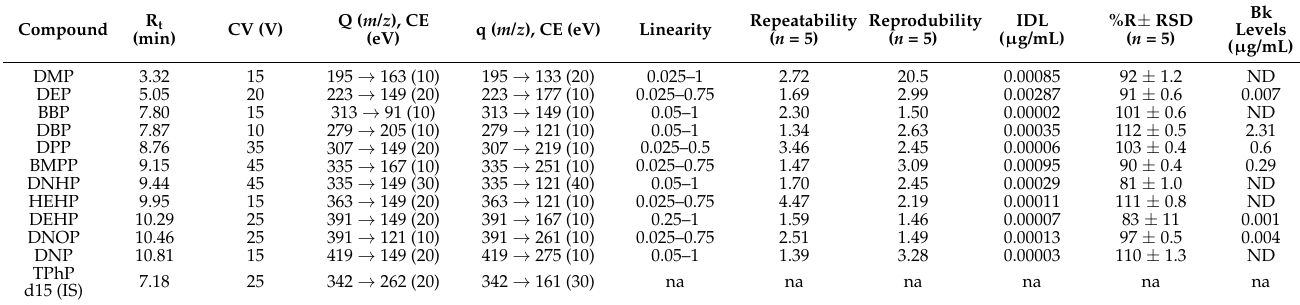
Table 2. Compounds studied ordered by retention time (Rt); CV = Collision Voltage; Q = quan- tification transition, q = confirmation transition, CE = Collision Energy. Quality parameters of the extraction and analytical method indicating linearity (R 2 > 0.99), repeatability and reproducibility (%), Instrumental Detection Limits (IDL), recovery (%R), and blank levels obtained in the migration experiments using water as